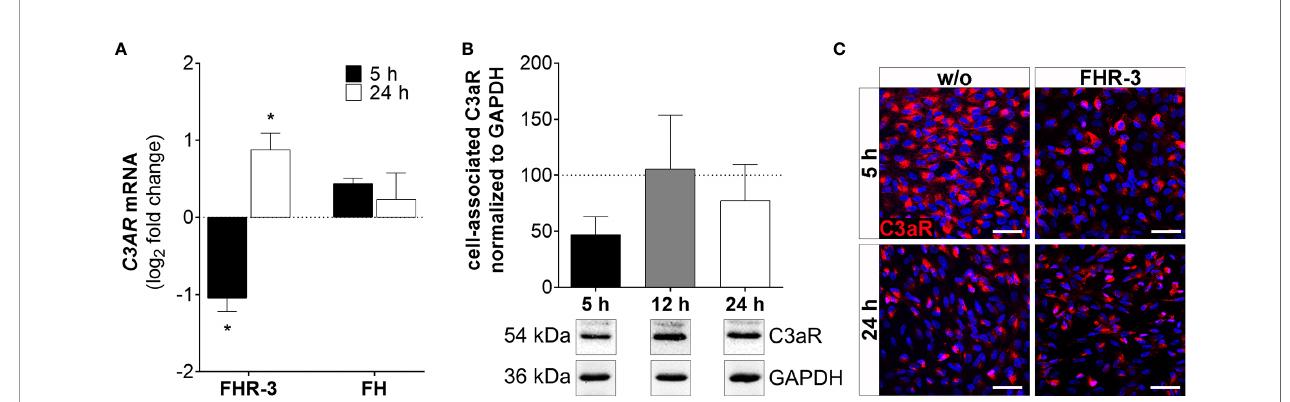
FIGURE 6 | C3aR expression was time-dependently regulated in FHR-3 stressed ARPE-19 cells. (A) C3AR mRNA expression was decreased after 5 h and increased after 24 h FHR-3 incubation. This effect could be con fi rmed on protein level: (B) Western blots of ARPE-19 cell lysates showed a tendency for decreased C3aR levels (54 kDa) 5 h after FHR-3 treatment. Supplementary Figure 1M shows full Western blots. (C) Decreased C3aR protein levels were detected by immuno fl uorescence using a speci fi c anti-C3aR antibody (red) after 5 h FHR-3 incubation (upper panels), whereas no differences between FHR-3 stressed and unstressed controls were observed after 24 h (lower panels). Scale bars 40 µm. w/o untreated control (dotted line). Mean with standard deviation is shown. *p < 0.05. (A) Wilcoxon matched-pairs signed rank test (n = 3); (B) Ordinary one-way ANOVA, Turkey ’ s multiple comparisons test (n = 3).